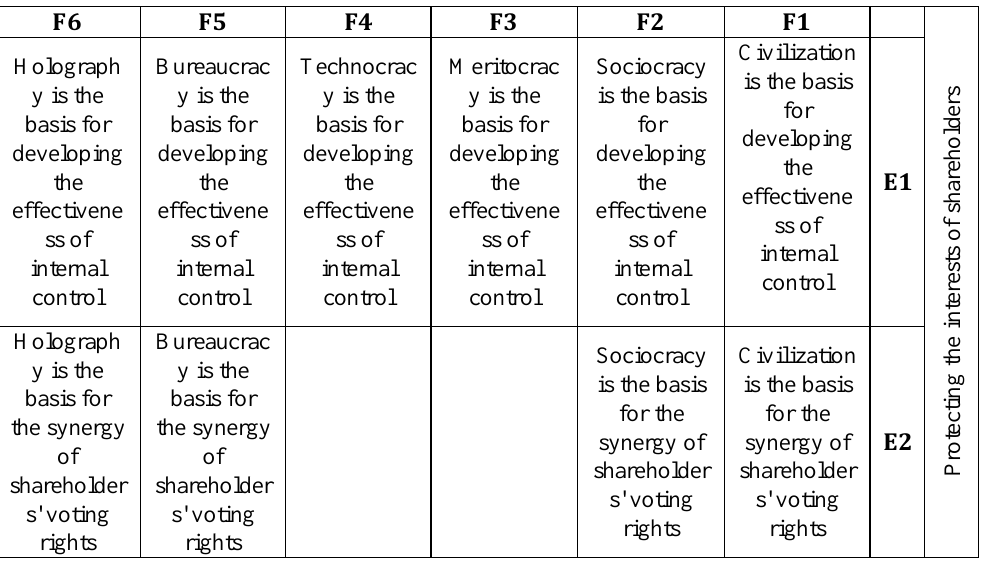
Table 9. Investor Protection Matrix Interpretation with Corporate Governance